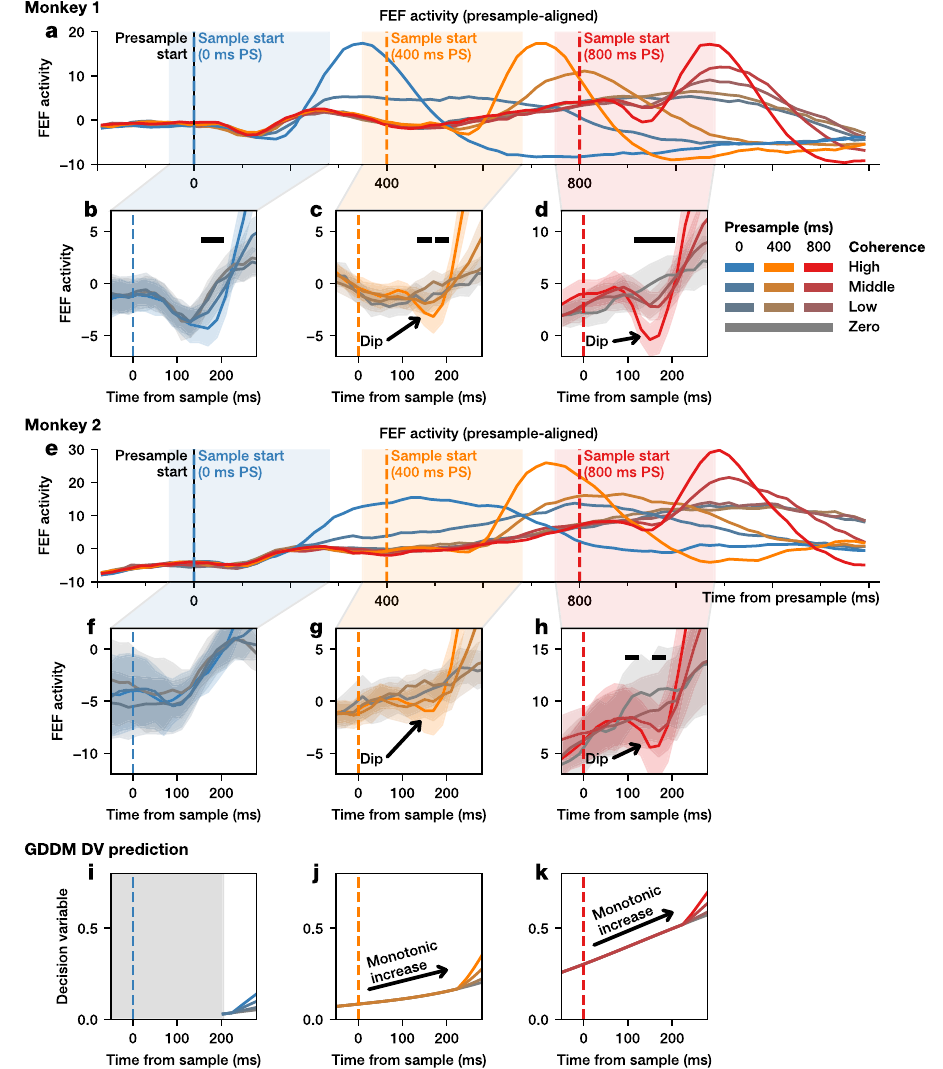
Fig. 3 Transient effect of changes in evidence on population FEF activity. The normalized population activity for all trials, aligned to the presample onset, for Monkey 1 ( a ) and Monkey 2 ( e ). b – d , f – h Highlighted is activity centered around the onset of the sample during trials with a 0- ( b , f ), 400- ( c , g ), and 800-ms ( d , h ) presample duration for Monkey 1 ( b – d ) and Monkey 2 ( f – h ). The black bar indicates signi fi cance ( p < 0.05, one-tailed test for a decrease in the mean, bootstrapping across neurons). Shaded regions represent bootstrapped 95% con fi dence interval of the mean. Predictions from a drift-diffusion model decision variable (DV) are shown below for the 0- ( i ), 400- ( j ) and 800-ms ( k ) presample durations. Light gray indicates no prediction within the model ’ s non-decision time. Activity is smoothed for visualization only, with signi fi cance testing performed before